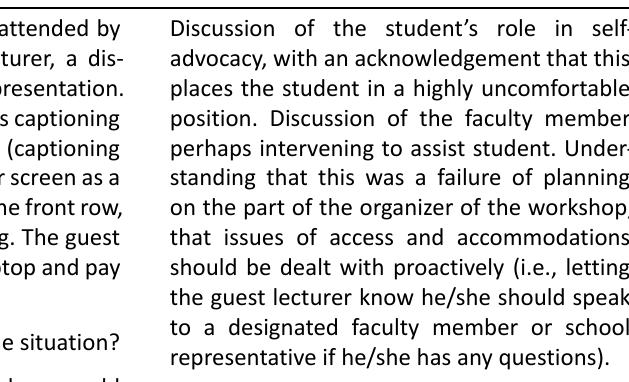
Table 1. Examples of Scenarios. Scenario